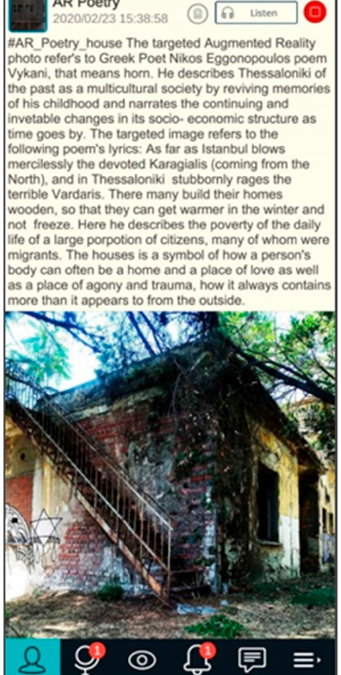
Figure 10. Example of a museum expert post regarding an exhibit.